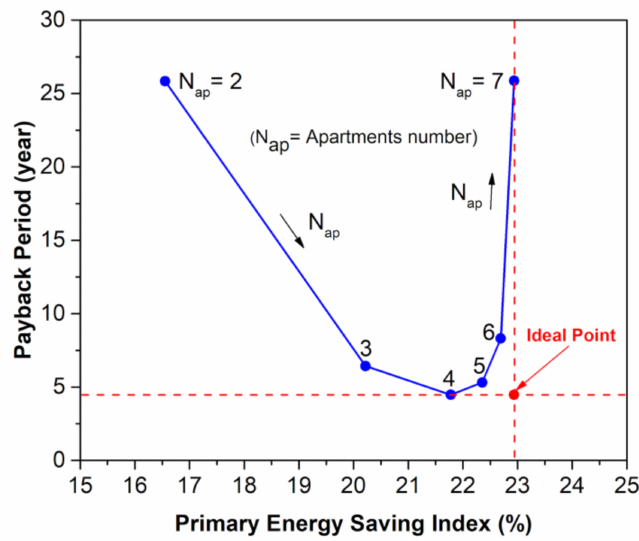
Figure 11. PBT as a function of the PES index for different